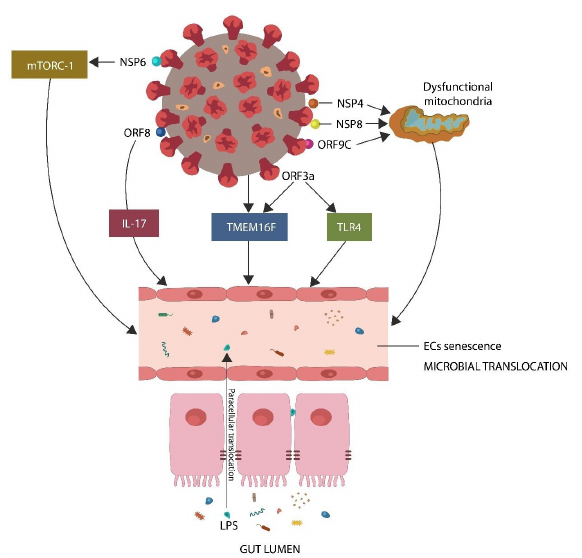
Figure 1. SARS-CoV-2 downregulates GABA by inducing endothelial senescence directly (by pro- tein – protein interactions) and indirectly (via mitochondrial dysfunction and ANG II upregulation). A dysfunctional endothelial barrier facilitates microbial translocation from the GI tract, where the flora is immunologically tolerated, into the systemic circulation, where it evokes inflammation and immunogenicity. Legend: NSP6, nonstructural protein 6, ORF8, open reading frame 8, IL-17, inter- leukin 17, TMEM16F, transmembrane protein 16F, TLR4, toll-like receptor 4, NSP4, nonstructural protein 4, NSP8, nonstructural protein 8, ORF9C, open reading frame 9C, ORF3a, open reading frame 3a, LPS, lipopolysaccharide. SARS-CoV-2-mediated GABA depletion likely explains the neuropsychiatric mani- festations of COVID-19, including anxiety, depression, posttraumatic stress disorder (PTSD), cognitive impairment, and seizure disorder [33 – 37]. In this perspective article, we take a closer look at the viral hijacking of endothelial, pancreatic, and gut GABA and the associated pathology. We also discuss potential inter- ventions for GABAergic system restoration. 2. Two Senescence Mechanisms in SARS-CoV-2 Infection SARS-CoV-2 is a single-stranded, enveloped RNA virus that contains four structural proteins: spike (S), nucleocapsid (N), membrane (M), and envelope (E). The S protein is composed of two subunits, S1 and S2. The former engages ACE-2, while the latter (FCS) interacts with furin, merging viral envelope and host plasma membrane as well as cells, thus forming syncytia [38]. The viral attachment to ACE-2 disrupts the physiological